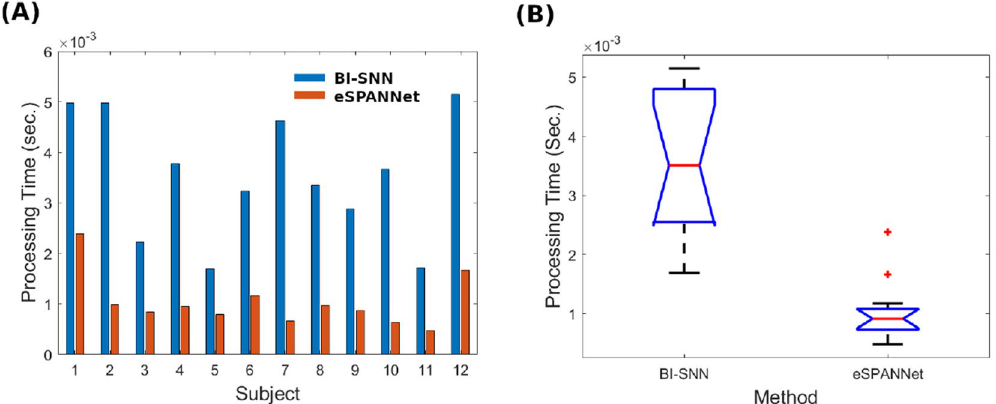
Figure 4. The feasibility of BI-SNN for real-time prediction. ( A ) The average prediction latency of a single time interval of the test EEG signal by each participant. ( B ) The statistical distribution of the average prediction latency within the participant